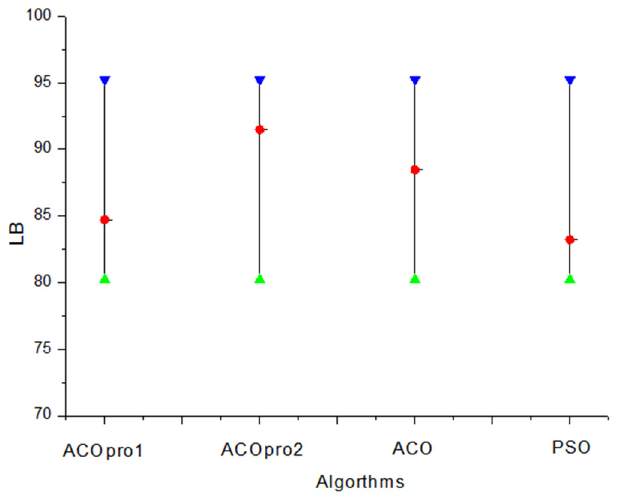
Figure 9. Minimum, average, and maximum values of the LB obtained by the comparison algorithms.